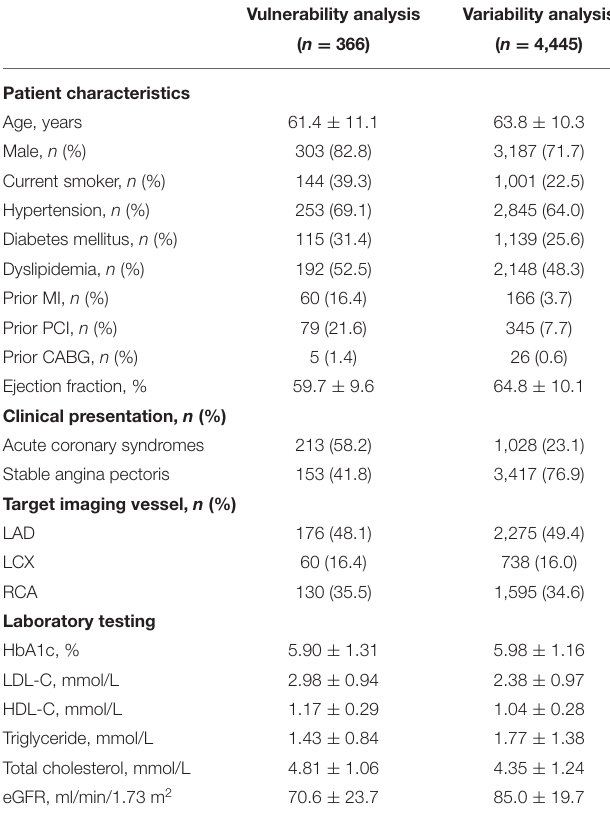
TABLE 1 | Patient